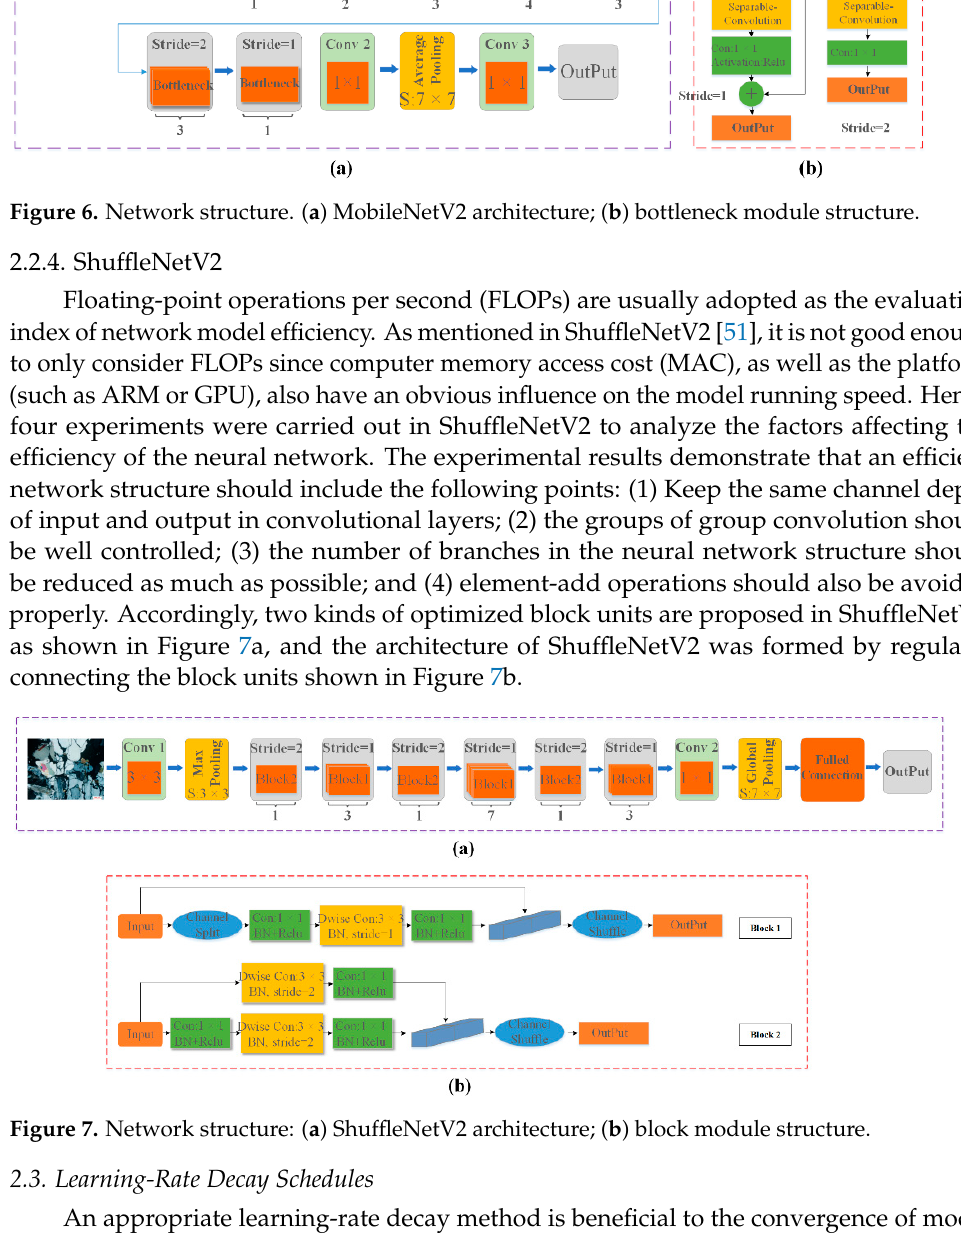
Figure 5. Depth-wise separable convolution structure.